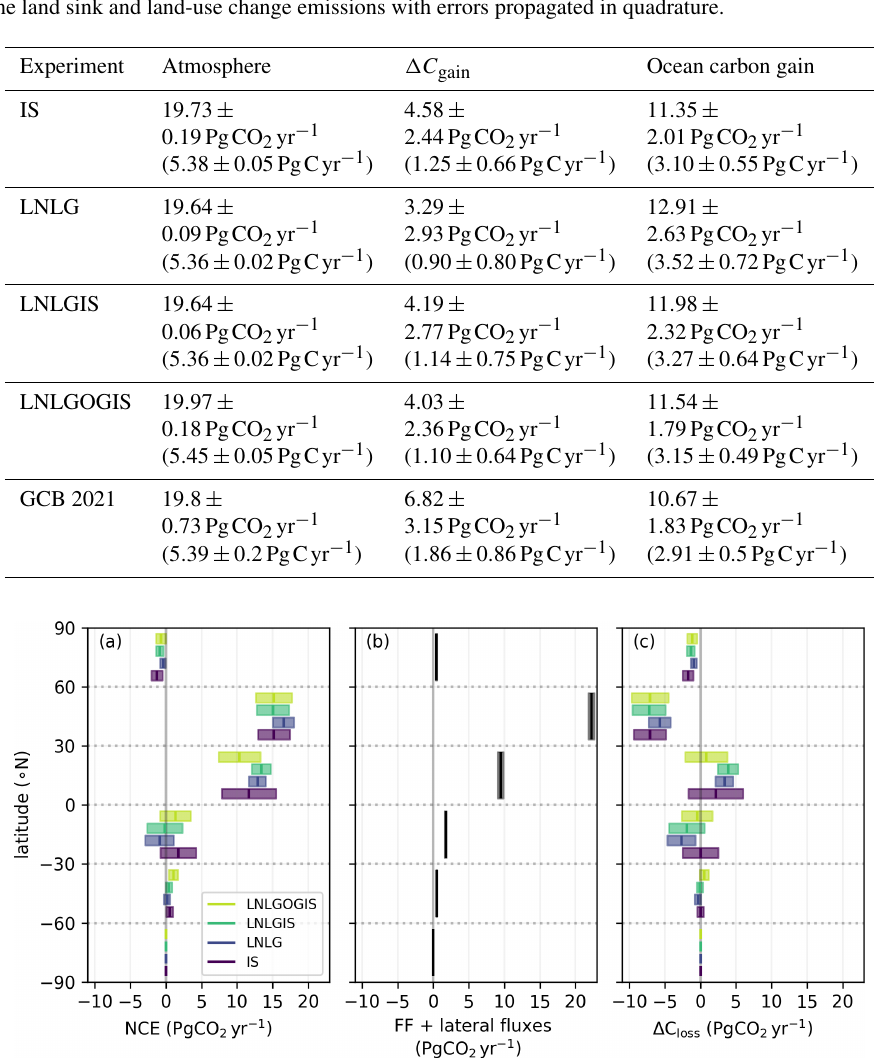
Figure 11. Zonal mean (a) NCE, (b) FF + lateral fluxes and (c) (cid:49)C loss for 30 ◦ increments of latitude based on 1 ◦ × 1 ◦ estimates averaged over 2015–2020. IS, LNLG, LNLGIS and LNLGOGIS median estimates are shown by solid lines, and 1 σ uncertainties are shown by the shaded